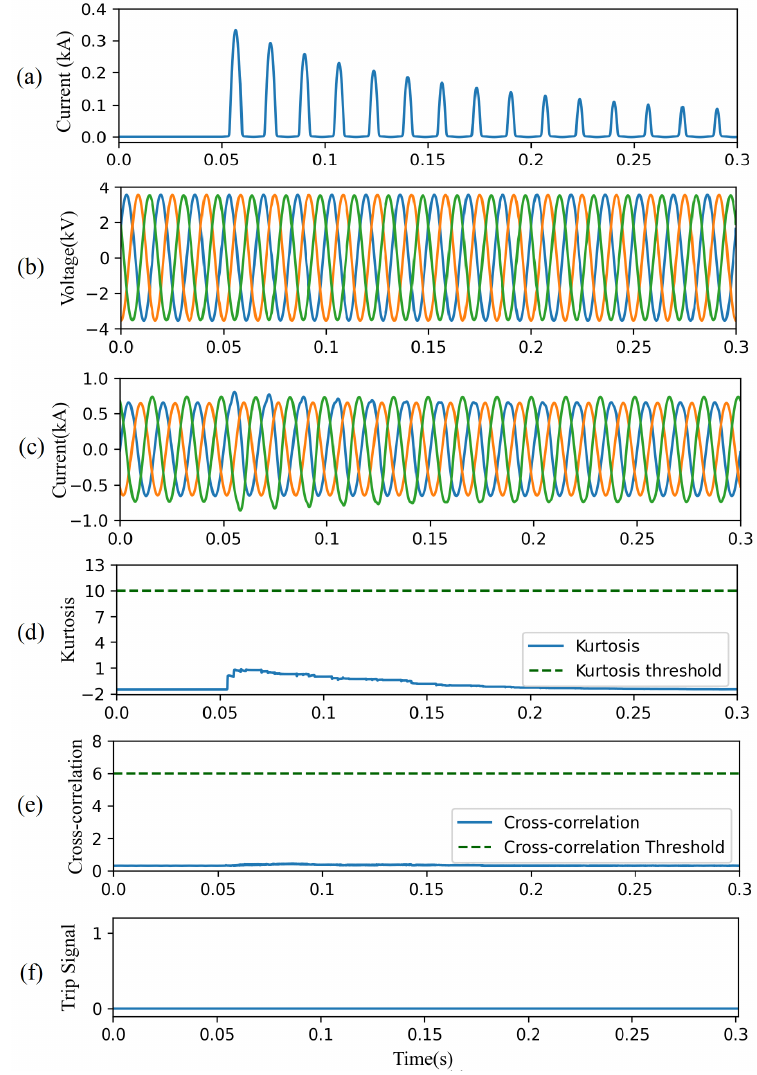
Figure 15. CAE-HIFD performance under inrush currents: ( a ) Inrush current, ( b ) three-phase input voltages, ( c ) three-phase input currents, ( d ) kurtosis, ( e ) cross-correlation, and ( f ) trip